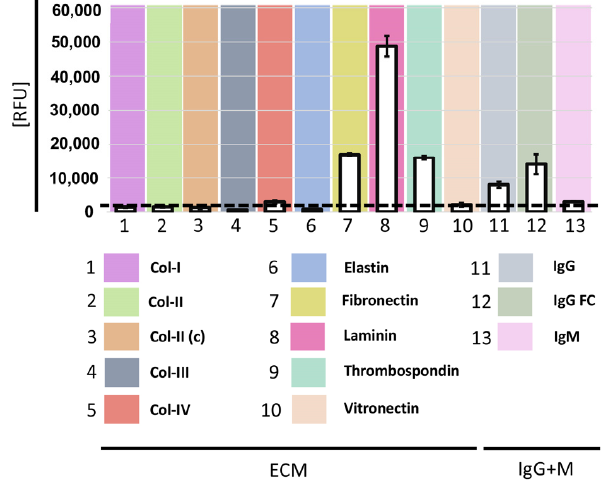
Figure 2. Binding of Gal-9 (5 µ g/mL) to a selection of normo-glycosylated ECM proteins in a microarray format. Results are expressed as relative fluorescence units (RFU) by averaging the background-subtracted fluorescence signals of four replicate spots, with error bars representing the standard deviation among the four values.